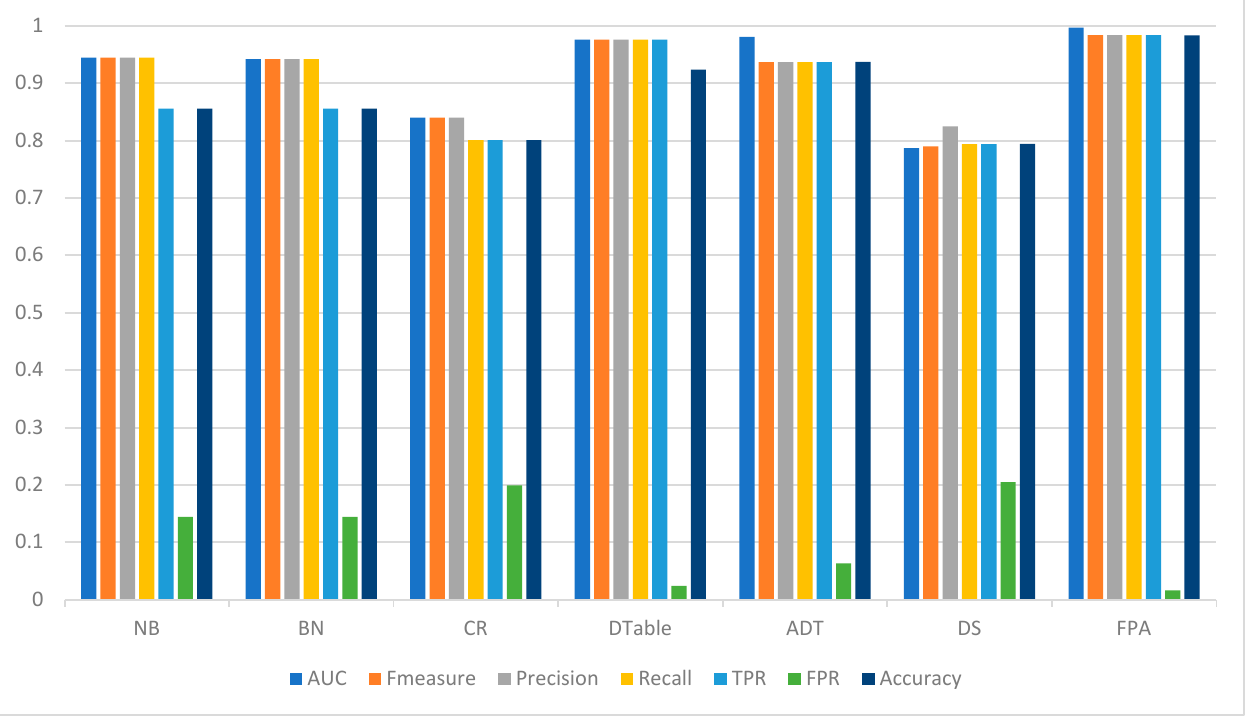
Figure 5. Android malware detection performance of FPA and baseline classifiers on the SMOTE- balanced Drebin dataset.